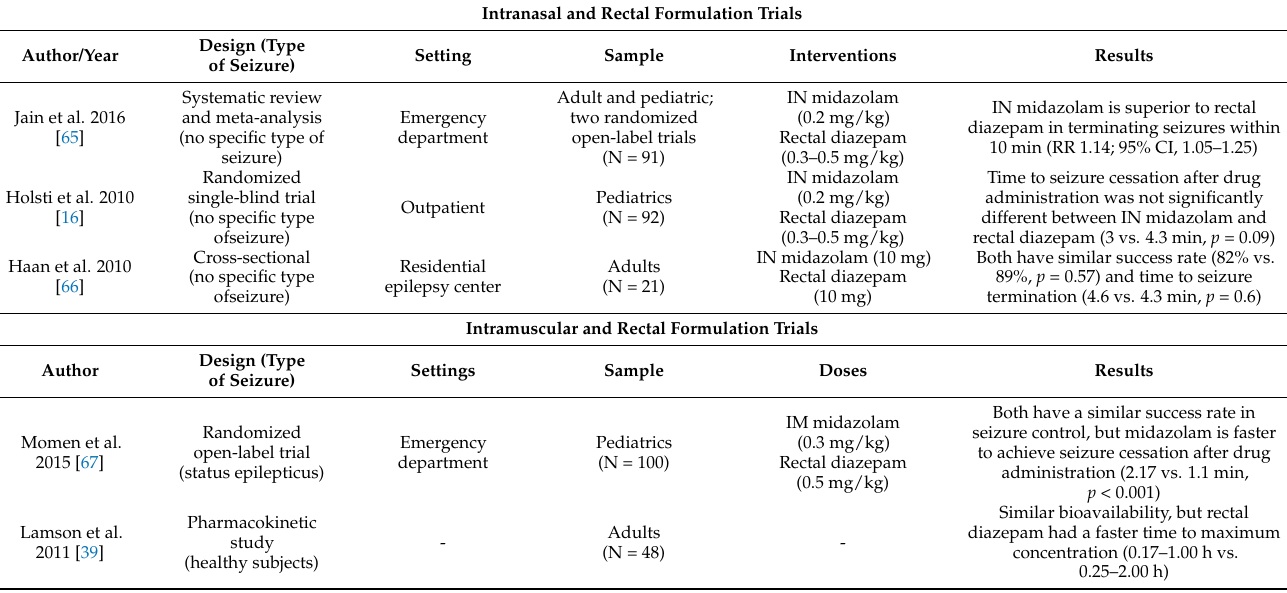
Table 5. Evidence supporting alternative routes of benzodiazepines